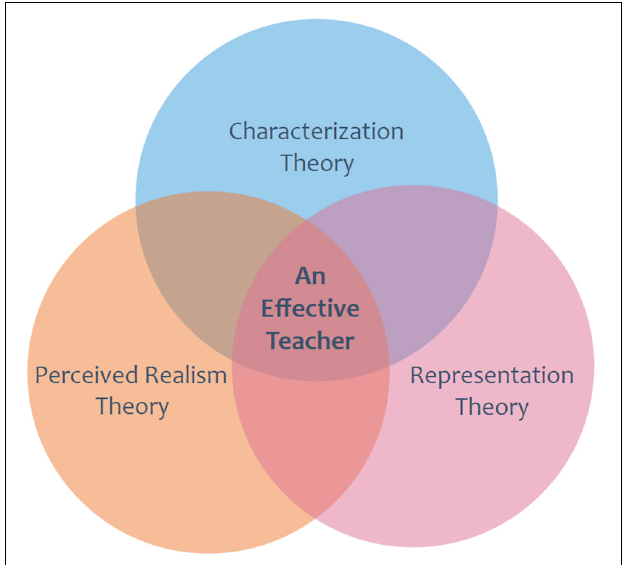
FIGURE 1 | Theoretical conceptualization of an effective teacher in popular